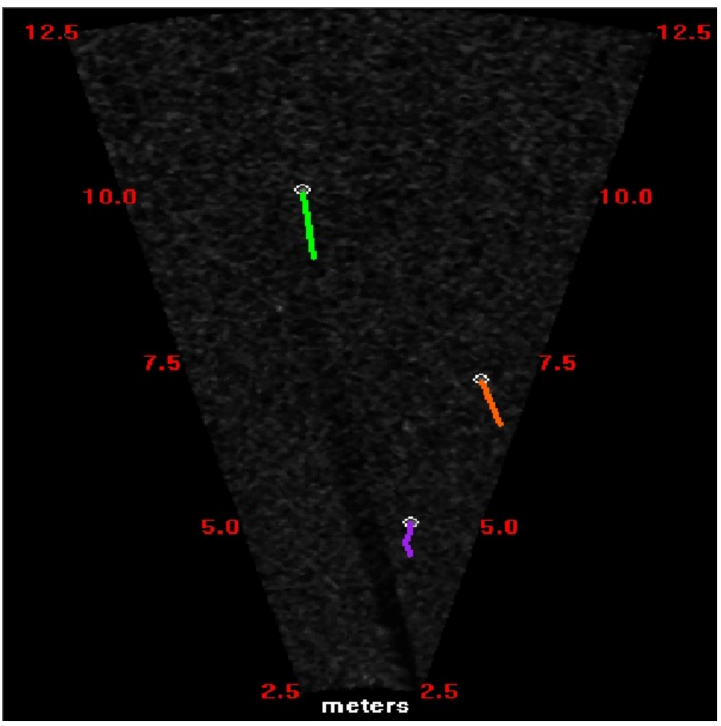
Figure 5. Diagram of tracking trajectories of multiple targets. Three different colored lines represent three different target